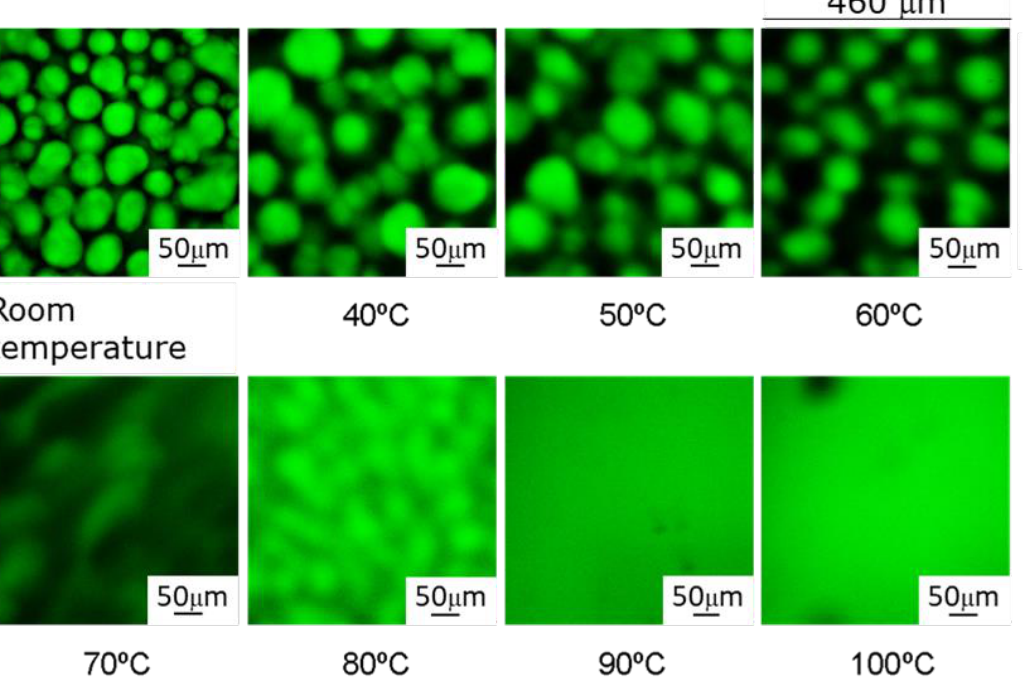
Figure 2. LSCM images of HDGEBA/PAMS cured up to the limiting conversion at different tem- peratures between room temperature and 100 ◦ C. Objective: 20 × . Scale bar 50 µ m; scanned area 460 × 460 µ m 2